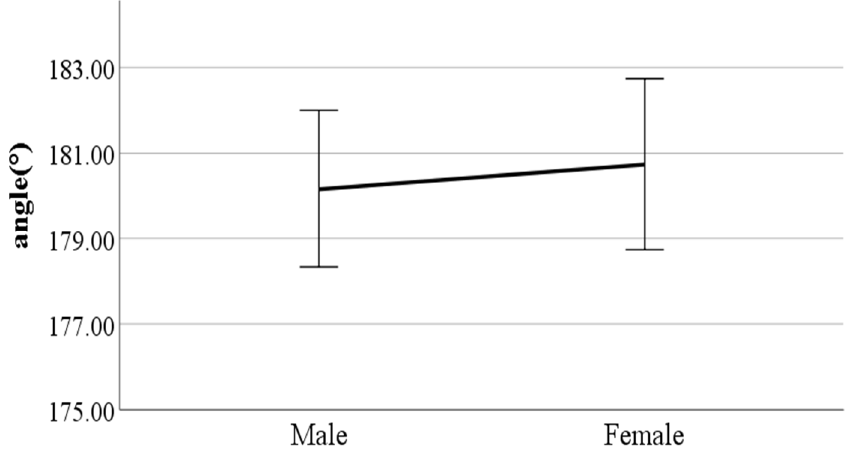
Figure 15. Gender difference in lateral trunk flexion at the double support phase (left foot forward (F value: 0.83, DF: 289, p -value: 0.01).